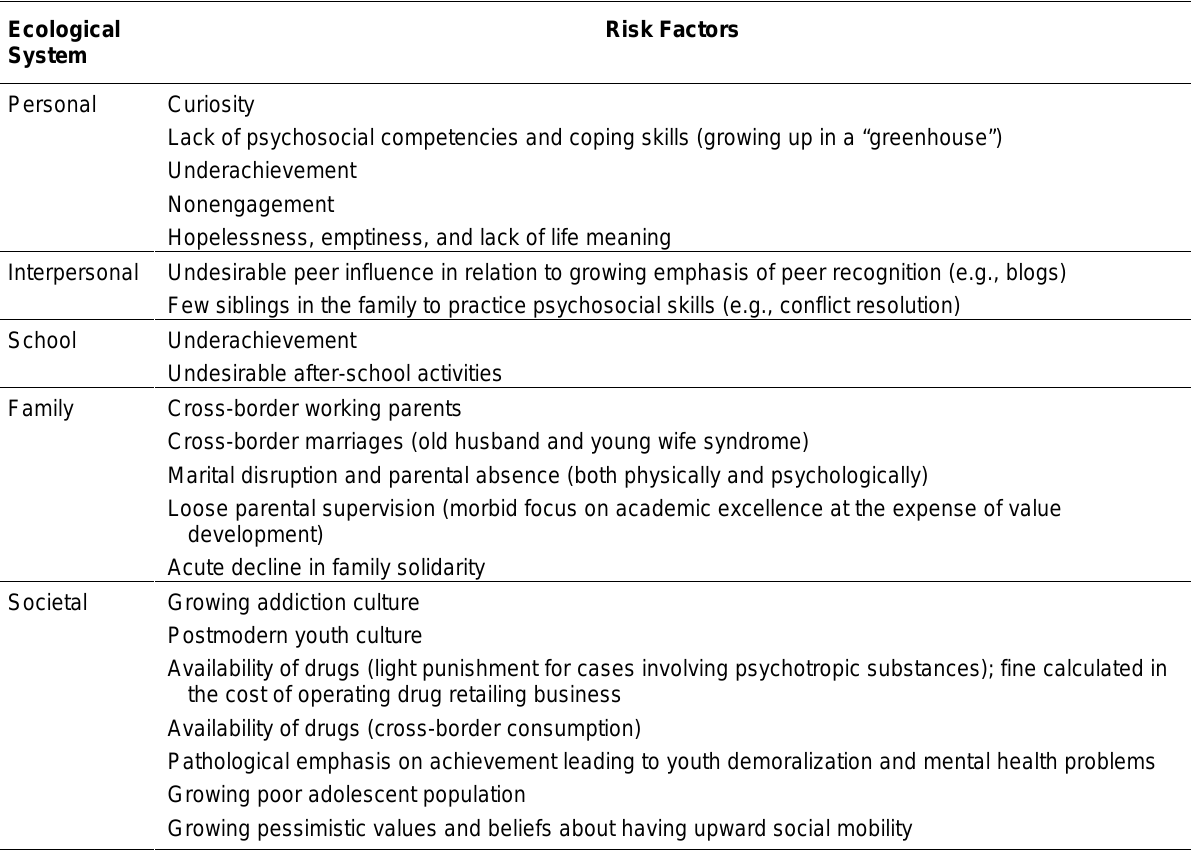
Summary of Ecological Factors Contributing to Adolescent Substance Abuse in Hong